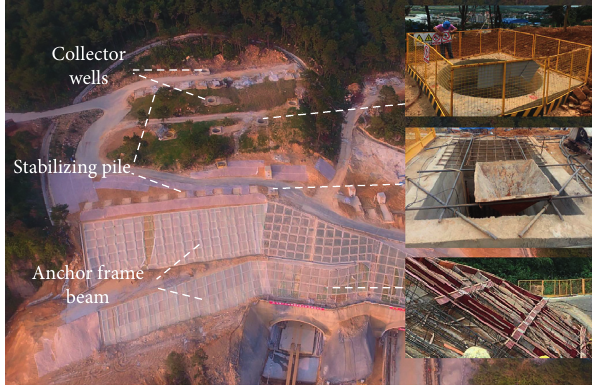
Figure 7: Deposit slope after stabilization work